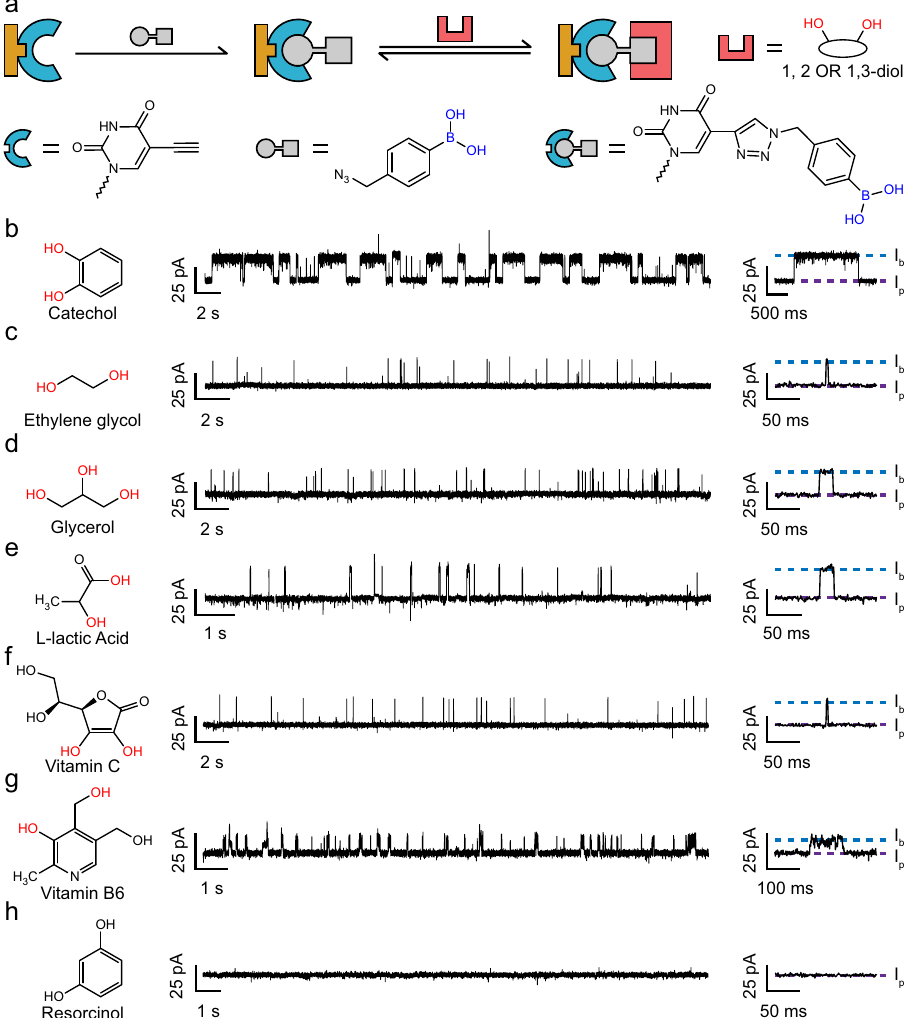
Fig. 3 PNRSS with phenylboronic acid. a Introduction of phenylboronic acid (PBA) and the corresponding reaction mechanism. A PBA was introduced with CuAAC as described in Supplementary Figs. 18 – 20. b – g The PBA on 14PBA serves as the fi xed reactant. Mobile reactants containing 1,2-diols or 1,3-diols, such as catechol ( b ), ethylene glycol ( c ), glycerol ( d ), L -lactic acid ( e ), vitamin C ( f ), or vitamin B6 ( g ), all report clear and distinct binding events. h Resorcinol, which lacks a compatible reactive group, fails to report any binding events. The experiments were carried out as described in ‘ Methods ’ . Catechol (500 µ M, b ), ethylene glycol (18 mM, c ), glycerol (12 mM, d ), L -lactic acid (5 mM, e ), vitamin C (1.6 mM, f ), vitamin B6 (50 µ M, g ), or resorcinol (1 mM, h ) were added to trans reaching the aforementioned fi nal concentrations. Corresponding scatter plots of 4 I vs. t off , results of 1 = τ on and 1 = τ off against different analyte concentrations and time histograms are provided in Supplementary Figs. 21 –